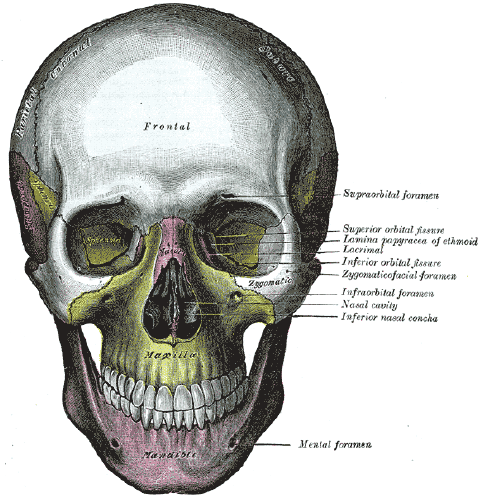
Figure 1. Craniofacial